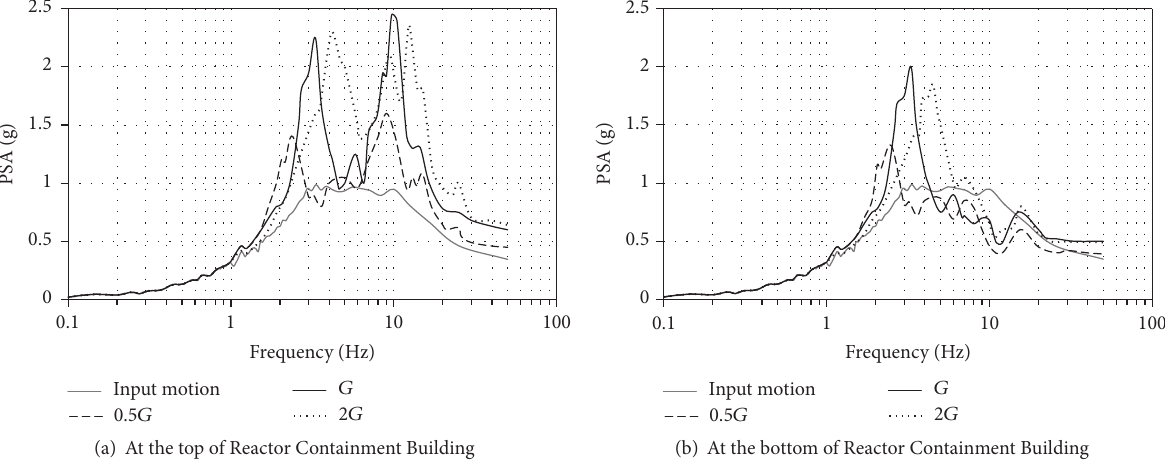
Figure 21: Comparison of response spectra acceleration under vertical excitation for different soil shear